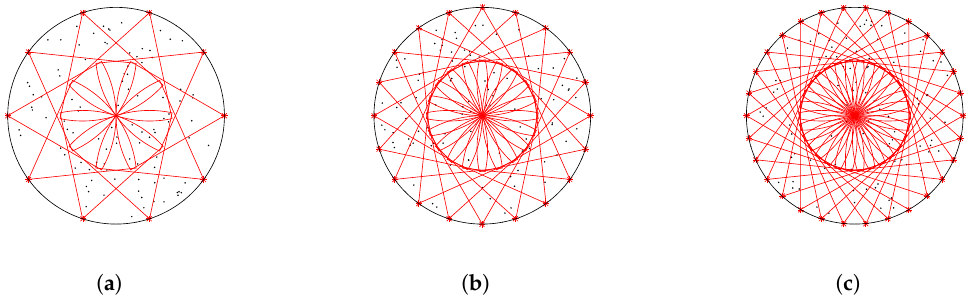
Figure 3. The simulation deployment for ( a ) 10, ( b ) 20 and ( c ) 30 chargers respectively.